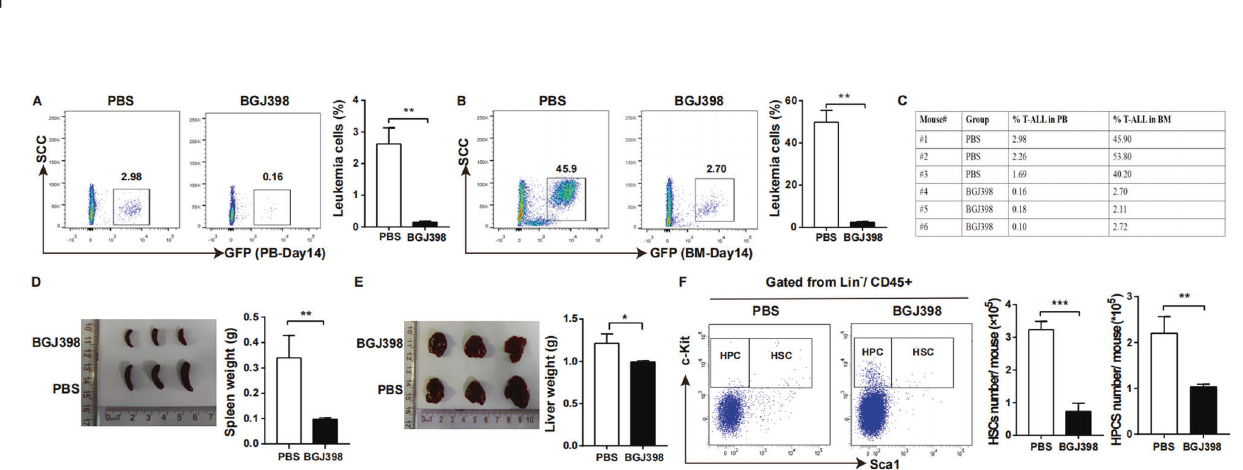
Fig. 5 The growth of T-ALL cells was suppressed after FGF2/FGFR2 blockade in vitro co-culture system. A Growth curve of Jurkat, TALL-1 and primary murine T-ALL cells co-cultured with MSCs from leukaemic mice supplemented with BGJ398. Vertical legend meant the ratio of surviving leukaemia cells to the initial number of leukaemia cells. B Jurkat, TALL-1, or primary murine T-ALL cells were co-cultured with leukaemic mice derived MSCs. Growth curve showed that the growth of T-ALL cells were inhibited after FGF2 knockdown in MSCs. C BGJ398 (1 μ M) was added to the co-culture system and 12 h later, the apoptosis rates of primary murine T-ALL cells (upper), Jurkat (lower) were increased. D Percentage of T-ALL cells in S phase was decreased after 12 h co-culture with BGJ398. E The apoptosis rates of primary murine T-ALL cells (upper), Jurkat (lower) were increased after co-culture with FGF2 knockdown MSCs for 12 h. F Percentage of T-ALL cells in S phase was decreased after co-culture with FGF2 knockdown MSCs for 12 h. G PCR results revealed that mRNA expression of cell cycle and apoptosis associated genes in T-ALL cells changed after addition of BGJ398 to the co-culture system. H Expression changes of cell cycle and apoptosis associated mRNA in T-ALL cells after co-culture with FGF2 knockdown MSCs. I , J Western blot results also revealed that P21, P27 and BAX were up-regulated and CDK2 was down-regulated after FGF2 and FGFR2 blockade. ( n ≥ 3, * P < 0.05, ** P < 0.01, *** P < 0.005).